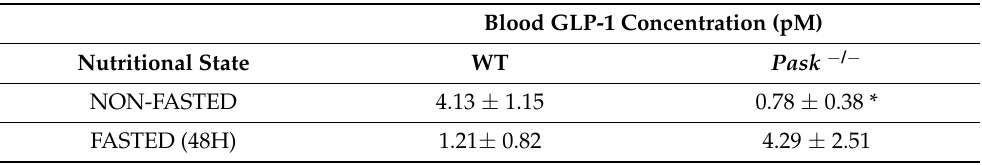
Figure 1. Exendin-4 regulates Pask gene expression in the liver and the expression of GLP-1 receptors, and serum GLP-1 levels are PASK-dependent. Quantitative real-time PCR was used to analyze the expression Pask mRNA level in liver from wild-type mice ( A ) were measured in WT non-fasted (NON-FASTED) and 48-h fasted (FASTED) specimens in the absence or presence of exendin-4 (Ex4) treatment, and the Glp1r mRNA from WT and PASK-deficient mice were measured in non-fasted (NON-FASTED) and 48-h fasted (FASTED) specimens ( B ). Pask mRNA levels ( A ) and Glp1r mRNA levels ( B ) were normalized by Rn 18s . Results are shown as mean ± SEM of 3–5 animals per condition and expressed as fold-over the non-fasted condition mean; # p < 0.05, ## p < 0.01 non-fasted vs. 48-h fasted, ǂ p < 0.05 vehicle vs. exendin-4 and * p < 0.05 WT vs. Pask − / − by two-way ANOVA followed by Tukey post-hoc test. Body weights were recorded in WT and PASK-deficient mice before and after 24 or 48 h of fasting ( C ). The percentage of weight lost was represented in the graph, where bars represent the mean ± SEM of 6–8 animals per group; *** p < 0.001 WT vs. Pask − / − by paired t -test. Table 1. Blood GLP-1 concentration in WT and PASK-deficient